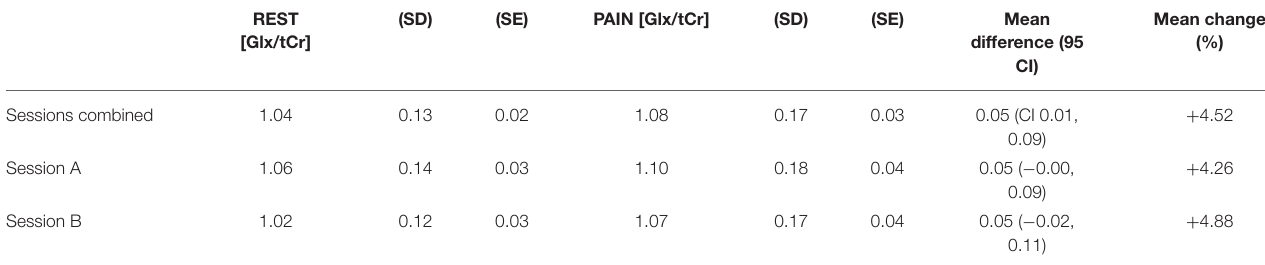
TABLE 3 | Mean Glx/tCr for REST and PAIN conditions and 1 Glx/tCr across combined and individual sessions in the dACC (ROI-2).